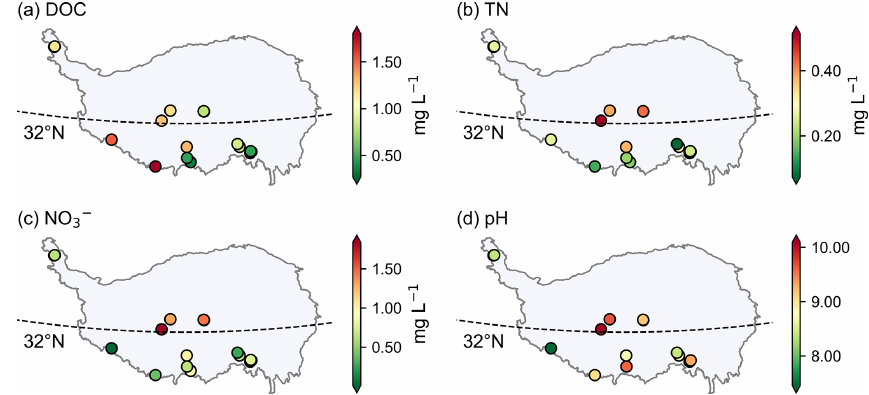
− (c) concentrations, and pH (d) for proglacial runoff on the Tibetan Plateau. 3